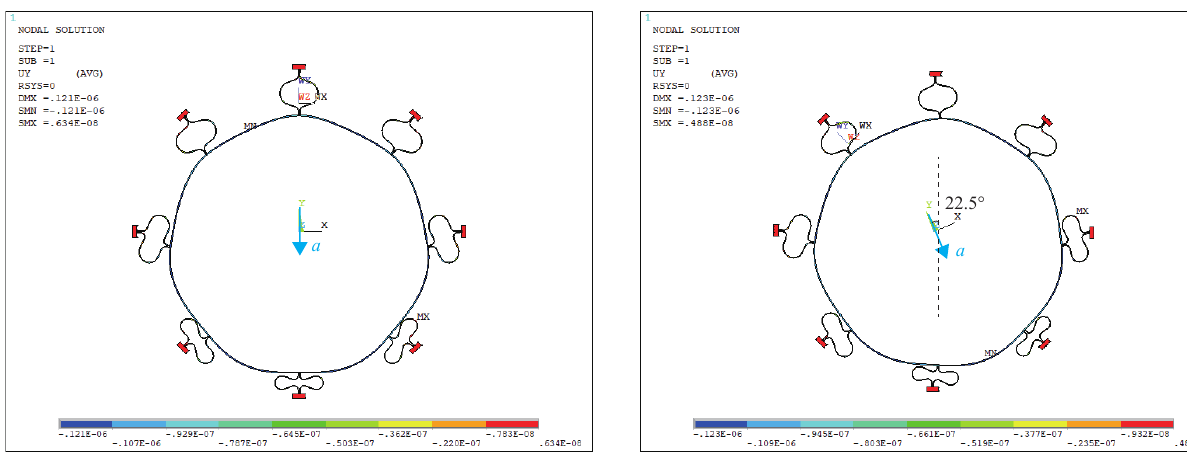
Figure 10. The displacement distribution of the ring gyroscope when the acceleration is 100